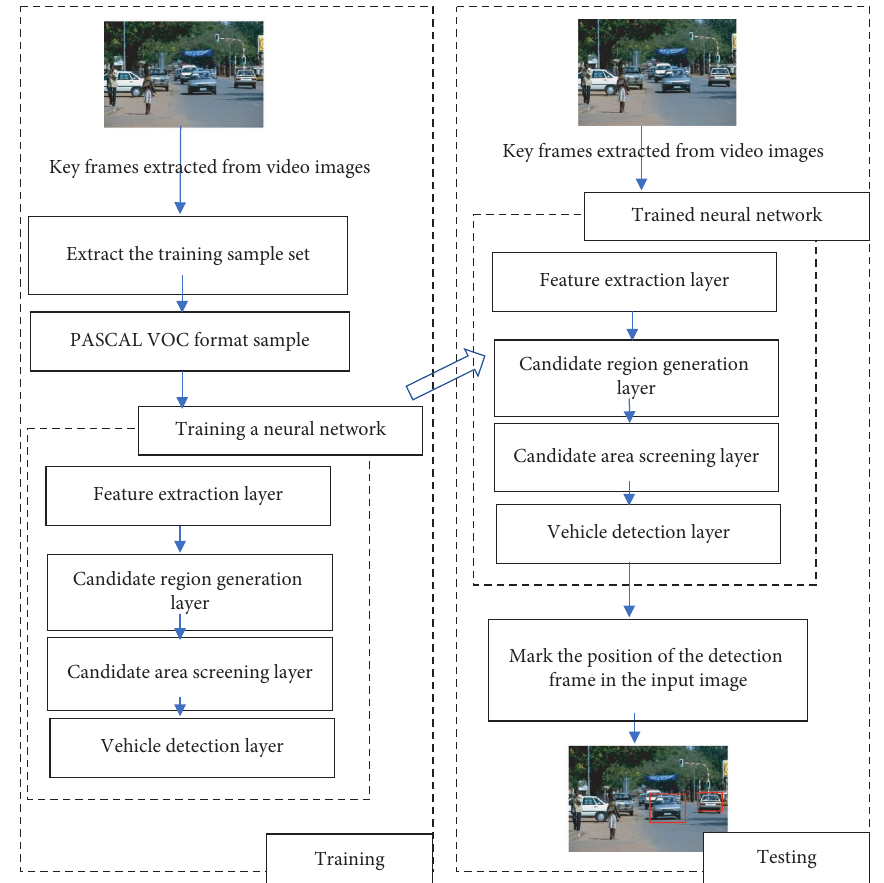
Figure 7: Vehicle detection algorithm flow based on faster